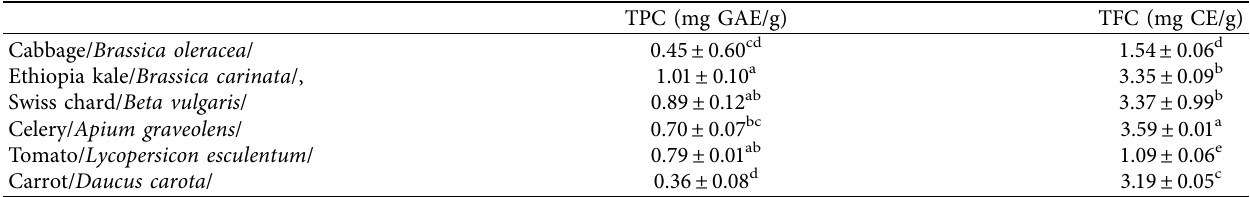
Table 5: Total polyphenol compounds content (dwb) of composite vegetable